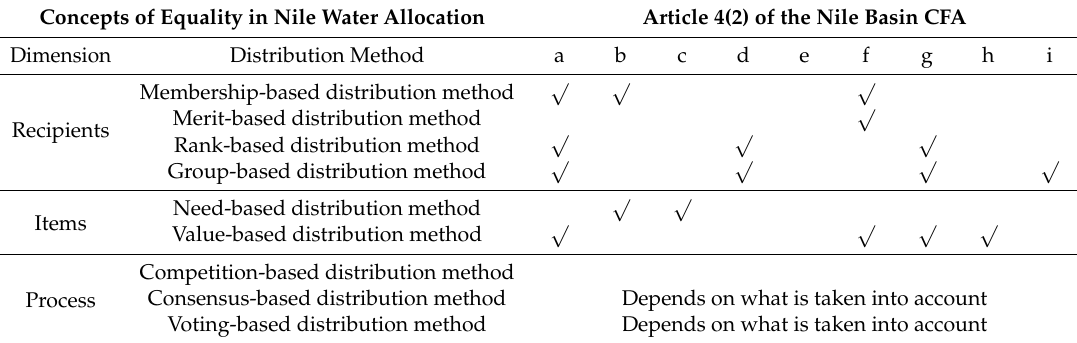
Table 6. Summary of the assessment results of the nine water allocation